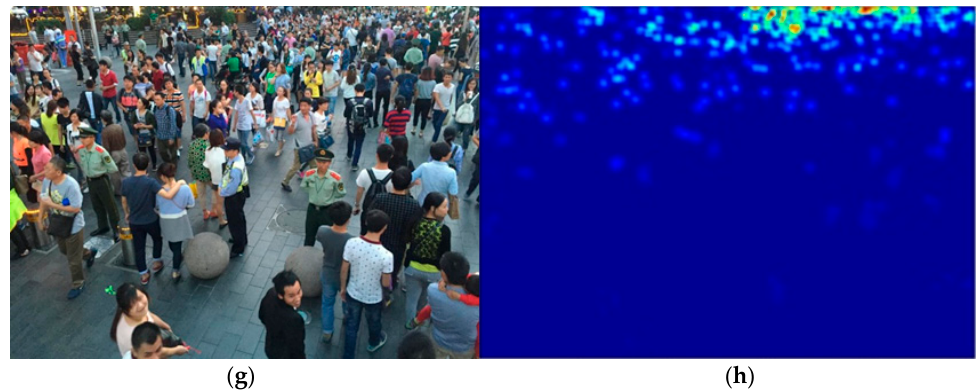
Figure 6. Experimental results on ShanghaiTech test set, ( a ) IMG_17 on Part A test sets (Ground truth: 1155); ( b ) estimated density map of ( a ) (Estimation: 1140.92); ( c ) IMG_172 on Part A test sets (Ground truth: 1171); ( d ) estimated density map of ( c ) (Estimation: 1173.49); ( e ) IMG_216 on Part B test sets (Ground truth: 161); ( f ) estimated density map of ( e ) (Estimation: 156.96); ( g ) IMG_293 on Part B test sets (Ground truth: 327); ( h ) estimated density map of ( g ) (Estimation: